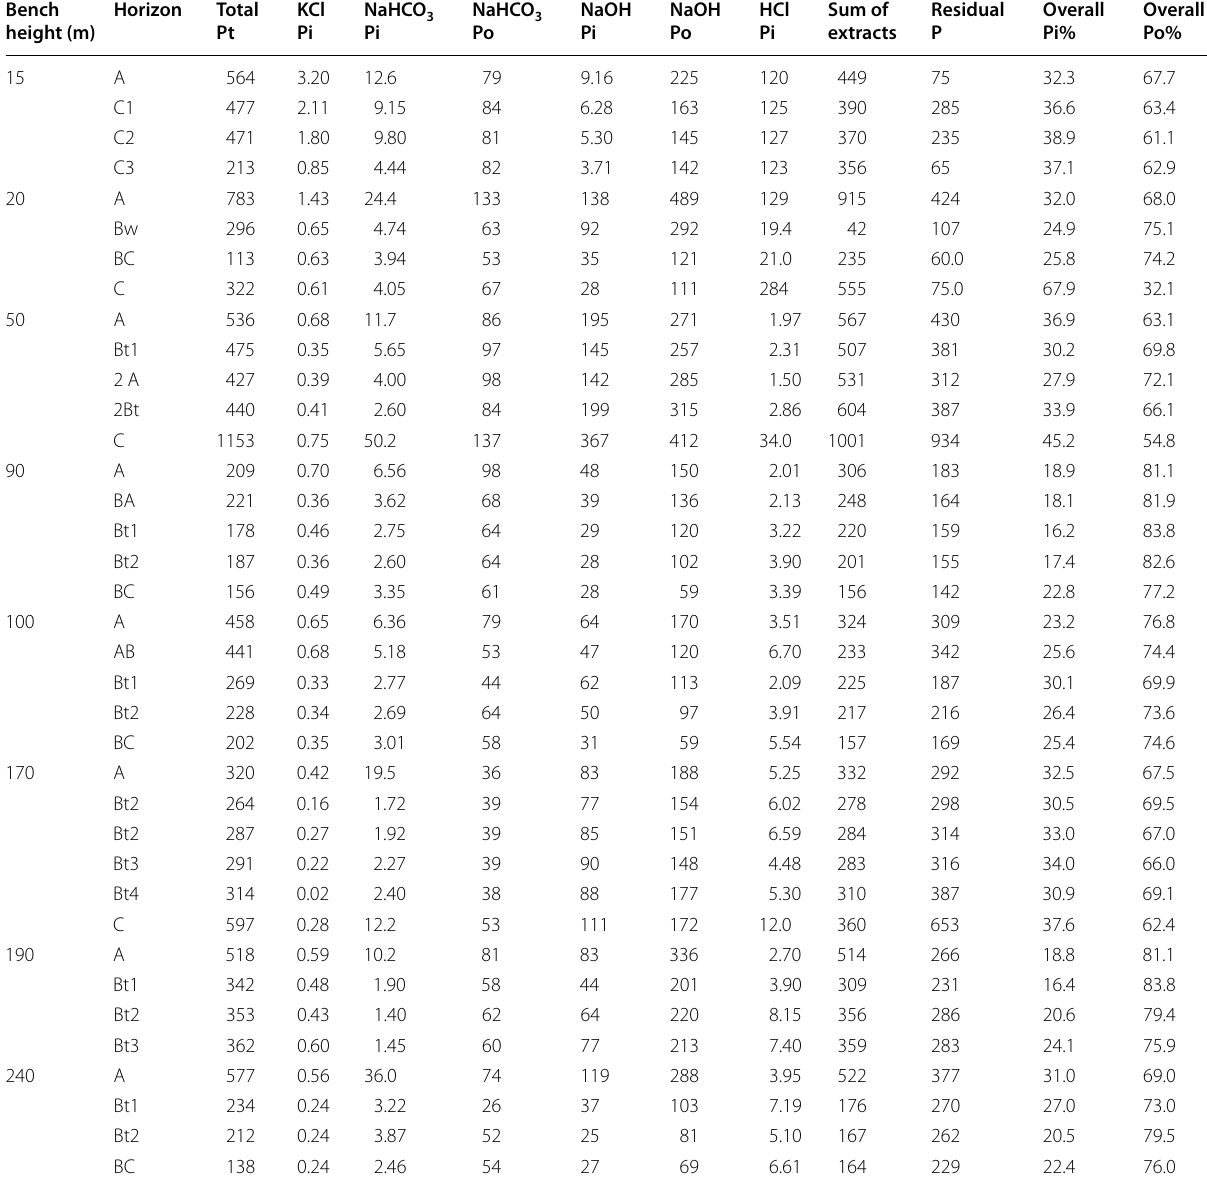
Table 3 P concentrations (mg kg − 1 ) in the soils of the Green Island chronosequence Bench Horizon Total KCl NaHCO 3 NaHCO 3 height (m) Pt Pi Pi